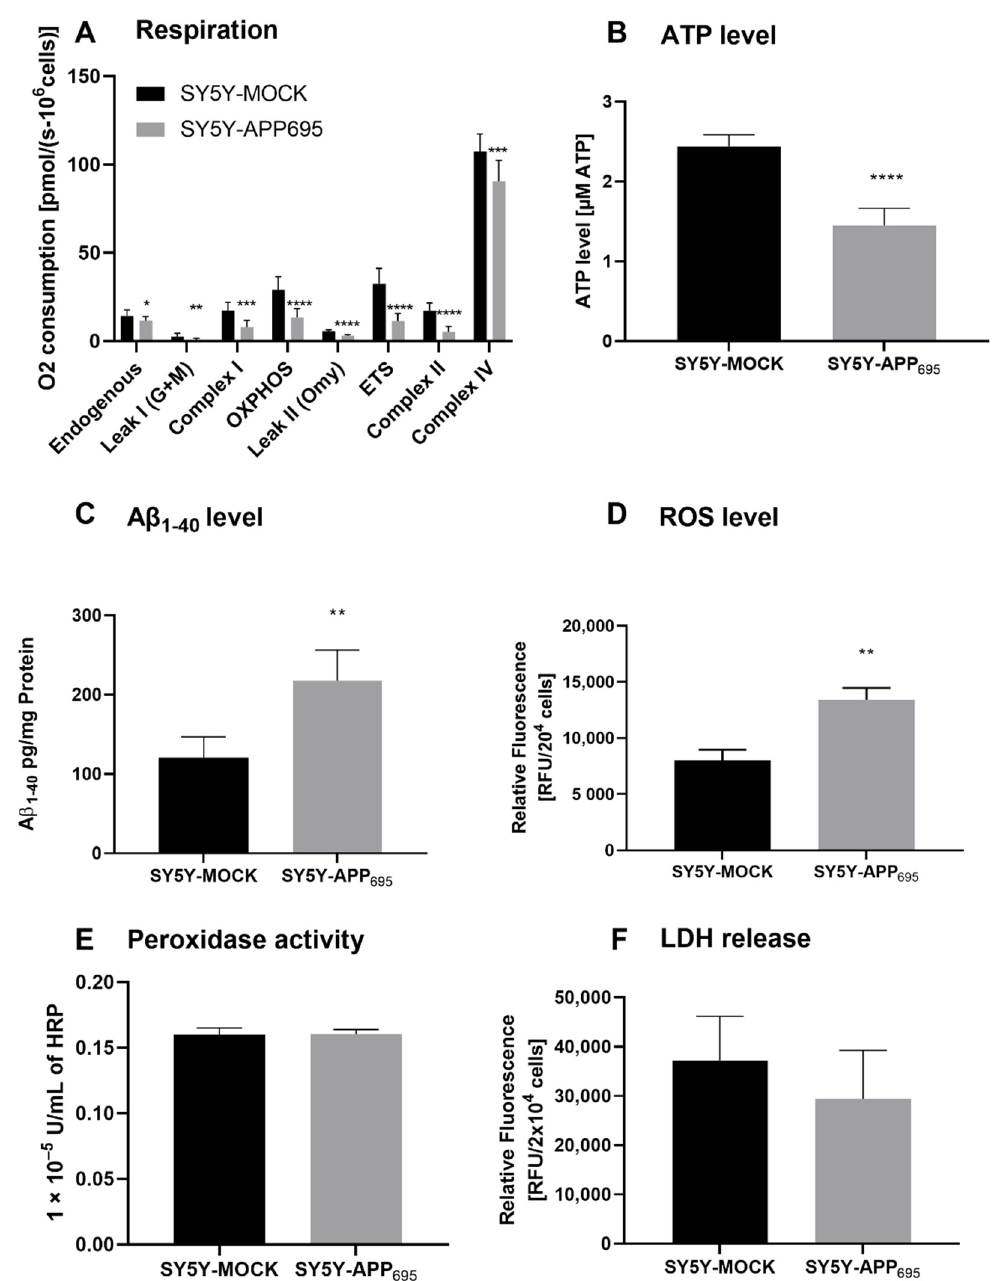
Figure 1. Respiration, ATP, A β 1-40 level, ROS level, and peroxidase activity of SH-SY5Y-APP 695 cells compared to SH-SY5Y- MOCK cells. ( A ) Respiration of SH-SY5Y-MOCK and -APP cells adjusted to cell count. Respective mean values ± SD are shown. * p < 0.05, ** p < 0.01, *** p < 0.001, and **** p < 0.0001. Significance was determined by Student’s unpaired t-test, N = 12. ( B ) SH-SY5Y-APP 695 cells exhibit reduced ATP levels compared to SH-SY5Y-MOCk control cells. ATP levels were determined after 24 h seeding by bioluminescence assay. Respective mean values ± SD are shown. Significance was determined by Student ´ s unpaired t-test (**** p < 0.0001), N = 8. ( C ) Concentration of A β 1-40 levels in SH-SY5Y-APP 695 cells compared to SH-SY5Y-MOCK cells. ** p < 0.01. Significance was determined by Student’s unpaired t-test. N = 6. ( D ) ROS levels in RUF/20 4 cells in SH-SY5Y-APP 695 cells compared to SH-SY5Y-MOCK cells. Respective mean values ± SD are shown. Significance was determined by Student ´ s unpaired t-test (*** p < 0.001), N = 8. ( E ) Peroxidase activity in SH-SY5Y-MOCK cells compared to -APP 696 cells. Respective mean values ± SD are shown. Significance was determined by Student ´ s unpaired t-test, N = 8. ( F ) Membrane integrity by LDH release level in RUF/20 4 cells in SH-SY5Y-APP 695 cells compared to SH-SY5Y-MOCK cells. Respective mean values ± SD are shown, N =